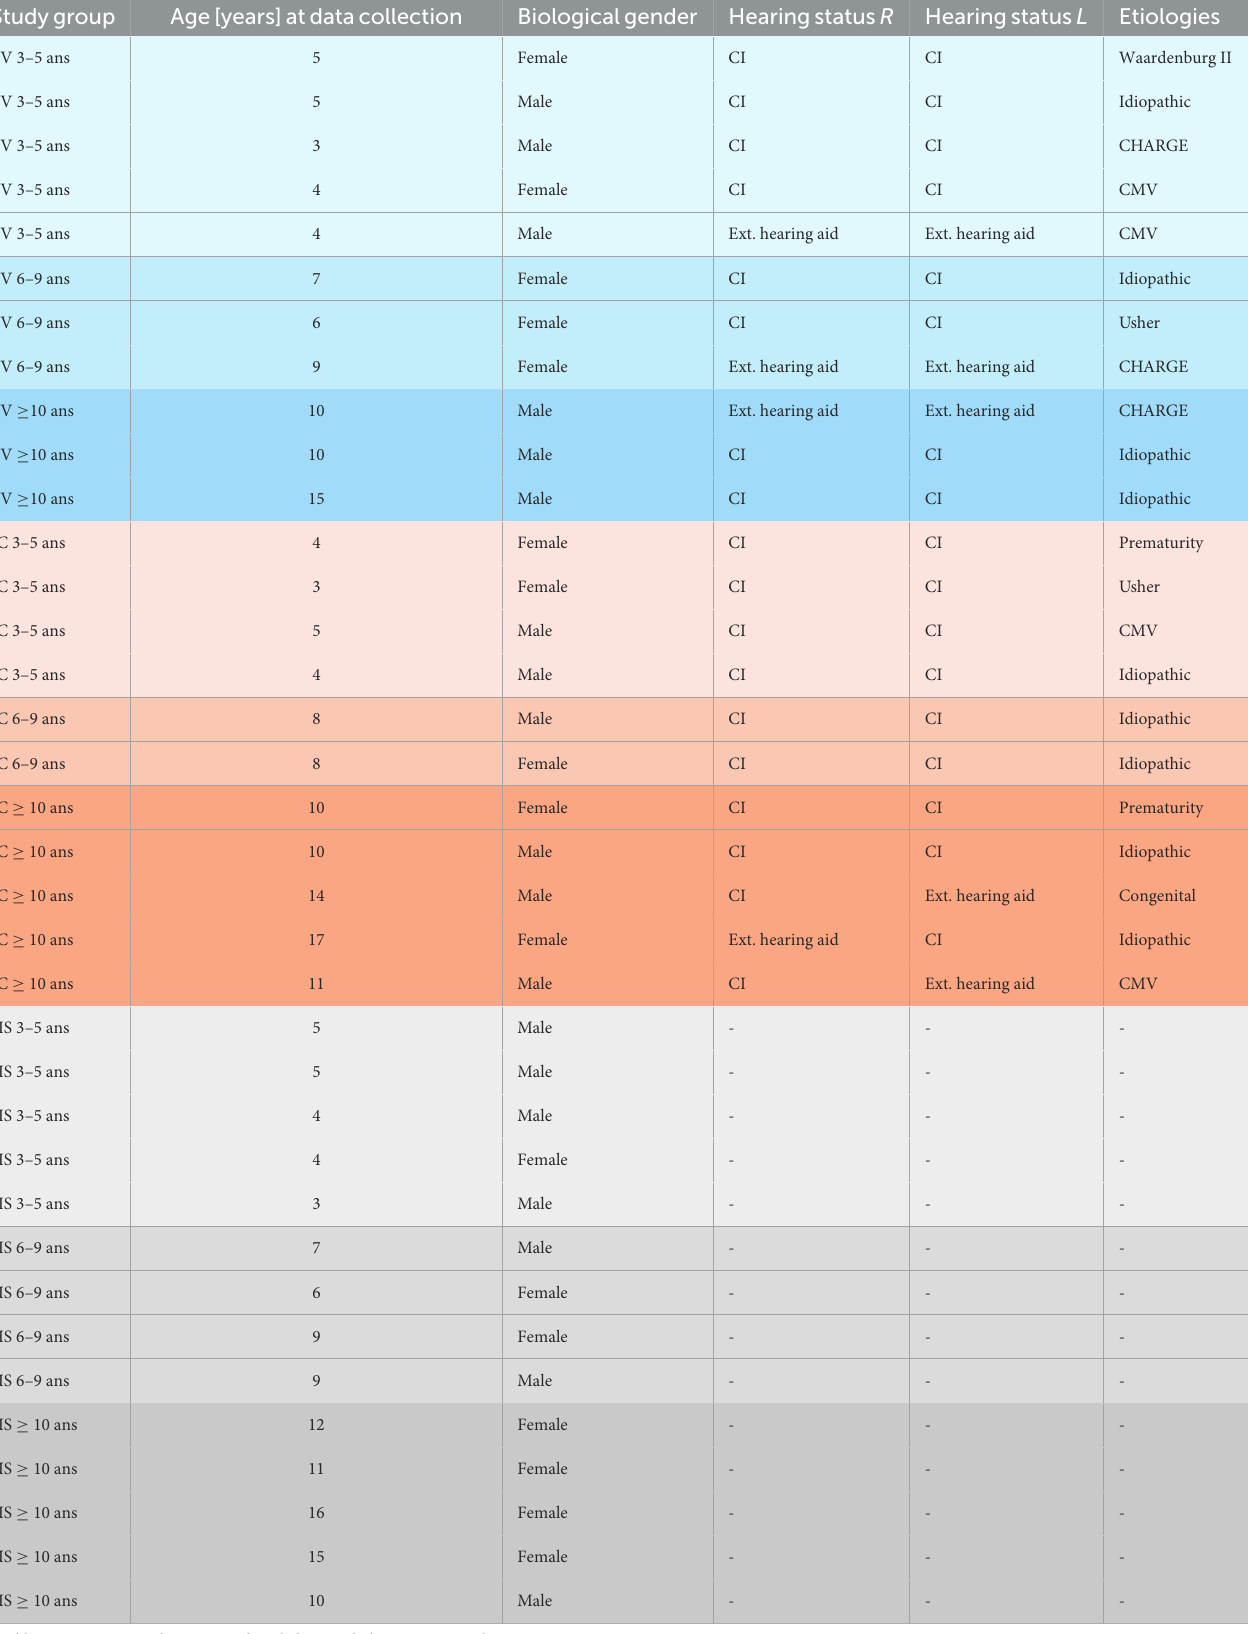
TABLE 1 Demographic characteristics of the participants included in the study. Study